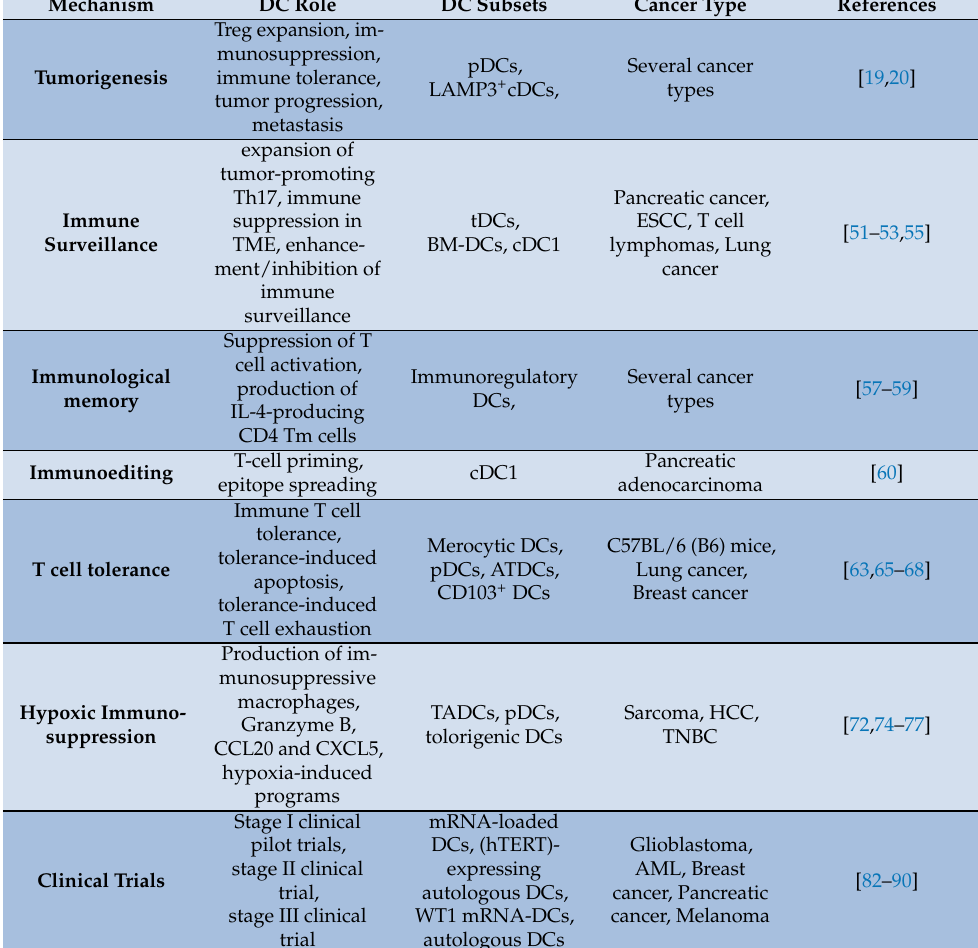
Table 1. Representative table summarizing the role of DCs in each review